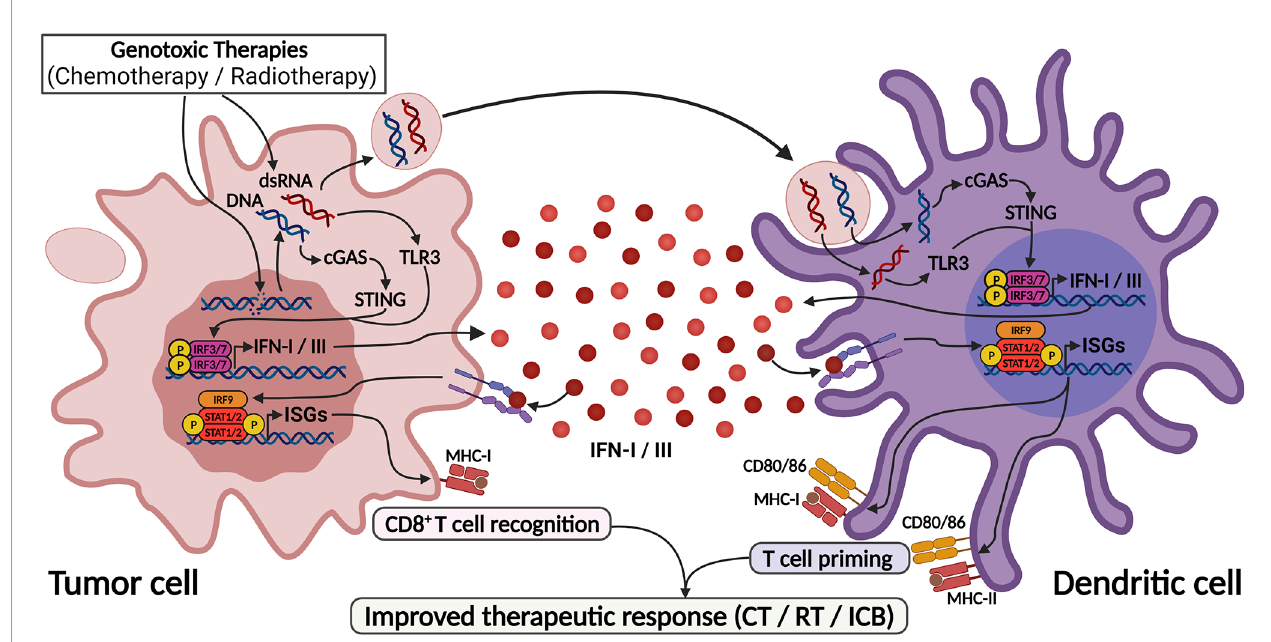
FIGURE 3 | DNA-damaging agents trigger IFN-I/III responses through activation of cGAS/STING and TLR3 pathways. DNA-damaging agents cause DNA leakage into cytoplasm as well as induce dsRNA formation, leading to the activation of cGAS and TLR3. Also, blebs from dying cell containing DNA and dsRNA are captured by dendritic cells and also sensitizes cGAS and TLR3 in these cells. These pathways culminate in IFN-I/III production by both cells, leading to ef fi cient dendritic cell activation and T cell priming, thus enhancing anti-tumor responses. This process mediates the response to genotoxic therapies and found the base for their use as adjuvants for ICB therapies. Created with